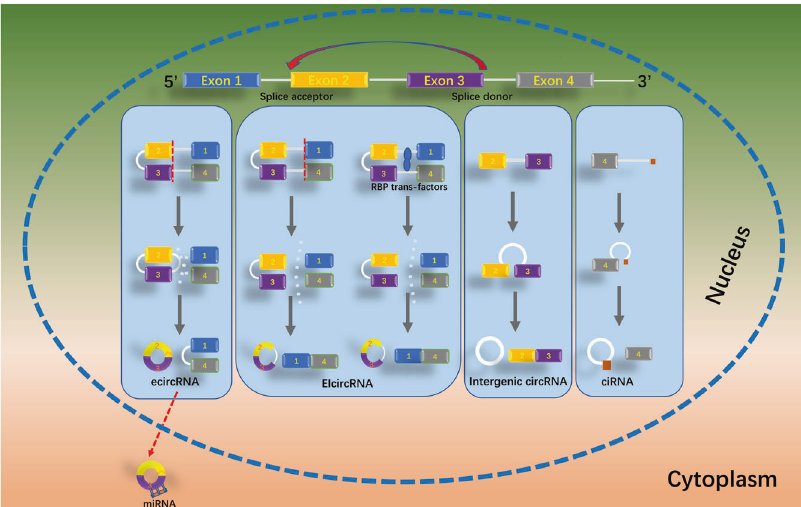
Fig. 1 Schematic diagram of classi fi cations of circRNAs. According to the biogenesis characteristics from genomic regions, circRNAs are often divided into four types, ecircRNA, EIcircRNA, intergenic circRNAs, and ciRNA. ecircRNA exon circRNAs, EIcircRNA exon – intron circRNAs, ciRNA circular intronic